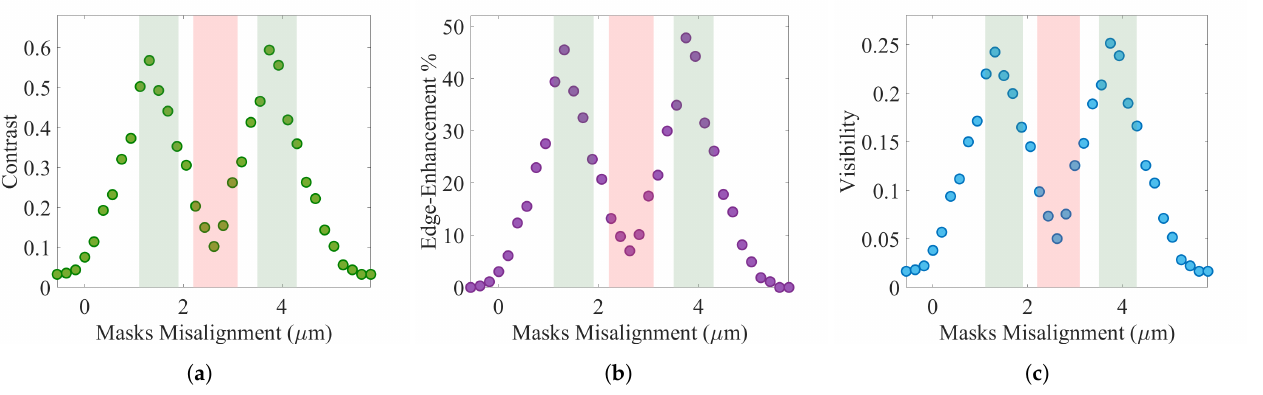
Figure 9. Simulation results of the behavior of contrast, edge-enhancement, and visibility of an EI- XPCi system versus masks misalignment carried out for a PEEK wire with 585 µ m in diameter. Dose efficiency, however, is considered as the amount of dose the object